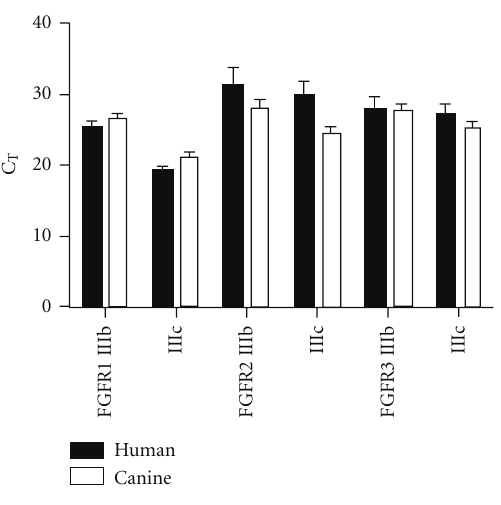
Figure 3: Expression patterns of FGFR1–3 IIIb and IIIc exons in human and canine STS cells. Preliminary data with quantitative real-time RT-PCR indicate that FGFR1-IIIc demonstrate lowest cycle threshold (Ct) values and thus is expressed strongest in canine STS tumors ( n = 13) and STS cell lines ( n = 7) originated from human STS tumors [58]. Bars and error bars represent mean with